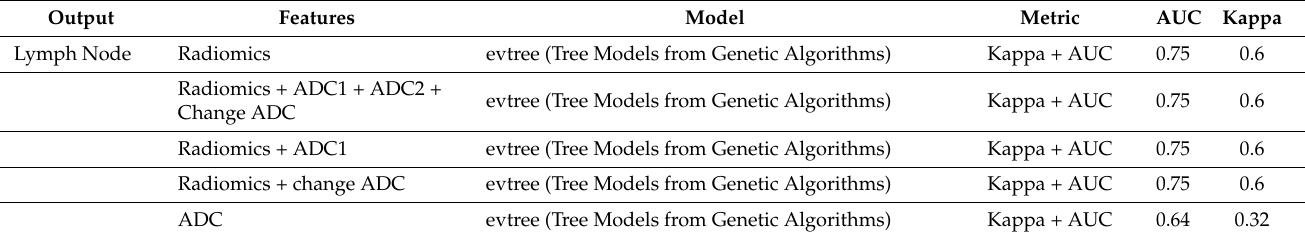
Table 5. Tabulated content of lymph node with relevant classifier algorithm and corresponding AUC with Kappa values.